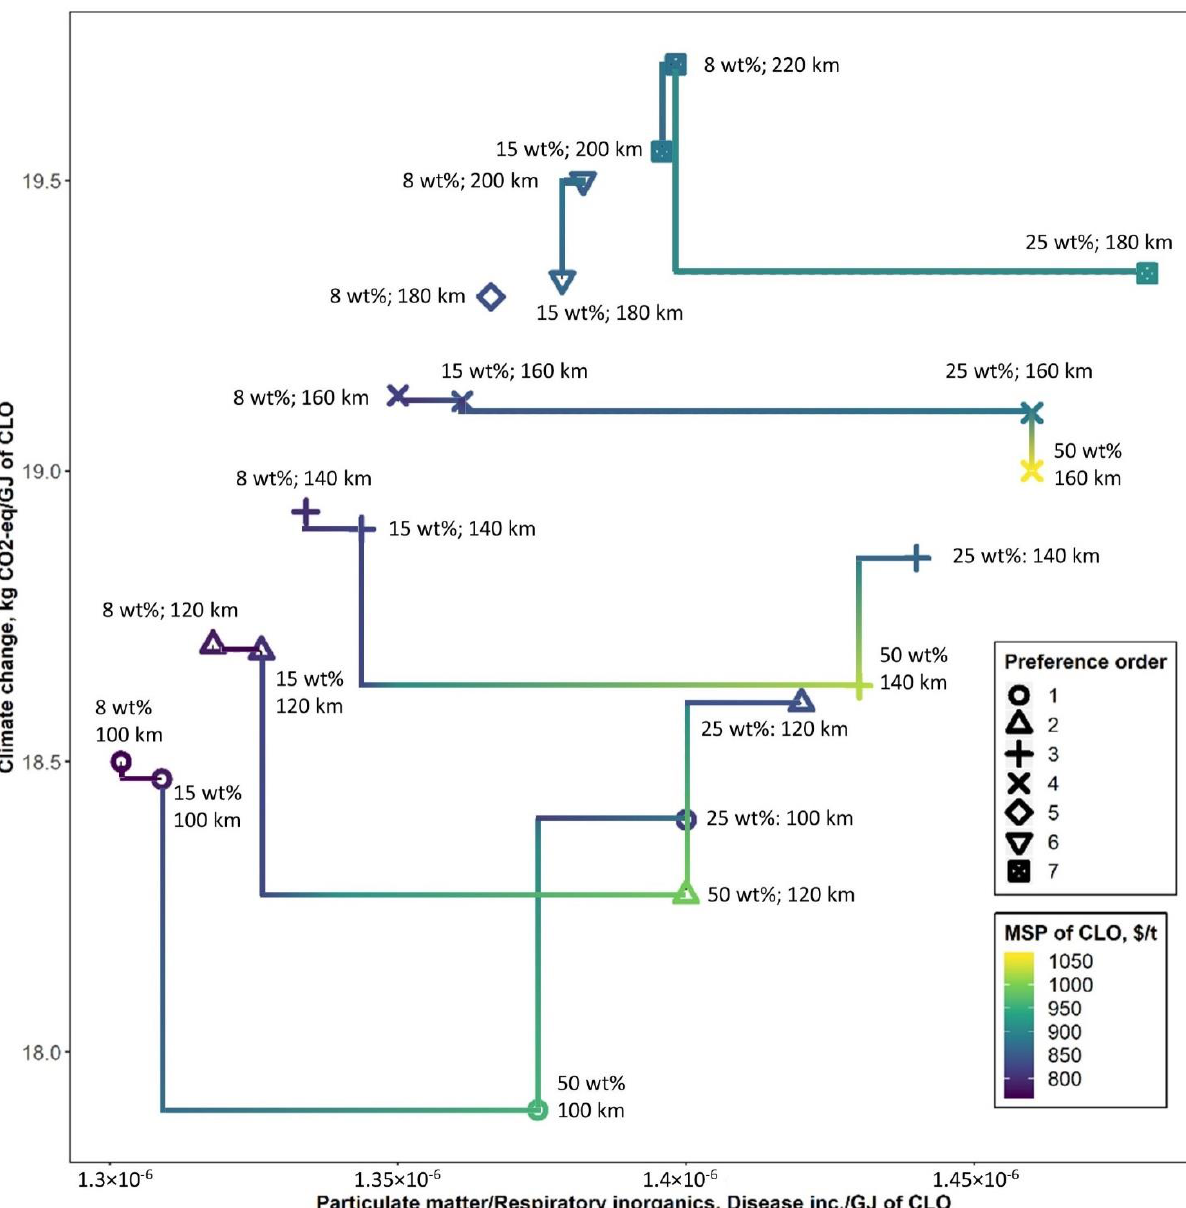
Figure 9. The Pareto front lines for each Pareto preference order of minimal GHG and PM